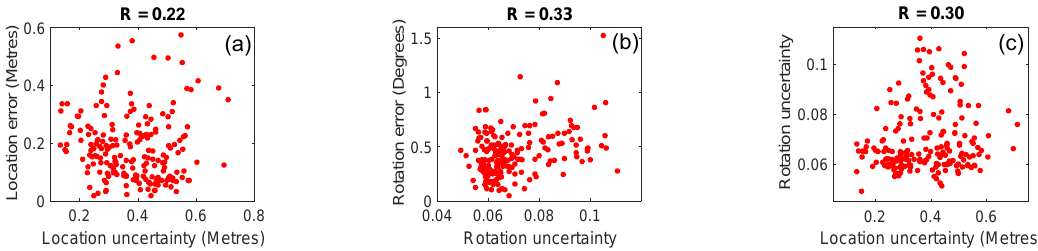
Figure 6. The modelled uncertainty by Recurrent BIM-PoseNet. ( a ) Estimated location uncertainty vs. location errors. ( b ) Estimated rotation uncertainty vs. rotation errors. ( c ) Estimated location uncertainty vs. estimated rotation uncertainty. R denotes the correlation factor.